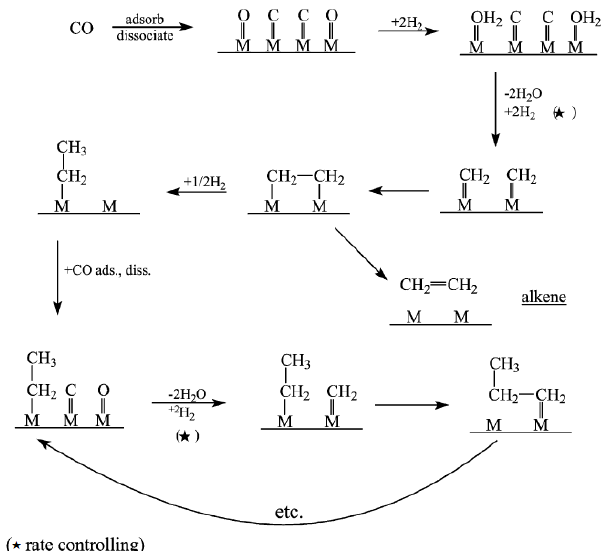
Figure 1. Schematic of carbide mechanism. Reproduced with permission [13]. ★ : rate controling step.